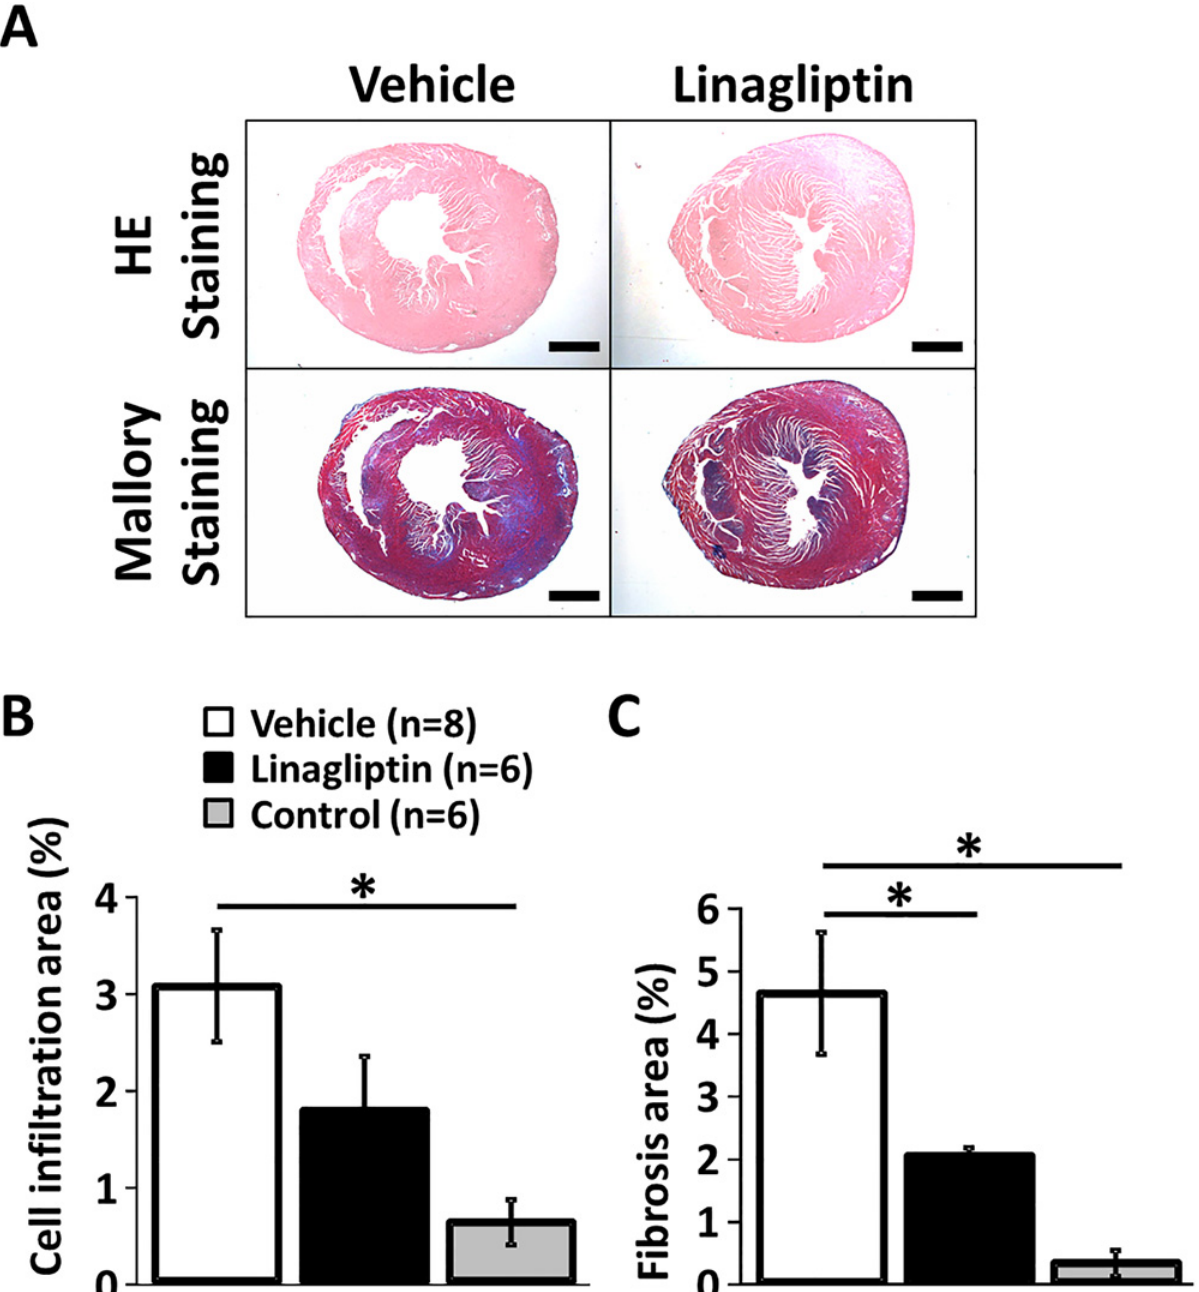
Fig 1. Pathological analysis revealed that a DPP-4 inhibitor prevented cardiac fibrosis in EAM. A, Representative pathological images stained with HE staining and Mallory staining in low (× 20) power microscopic field are presented. B, Quantitative analysis of the cell infiltration area in myocardium. There is no significant difference between the untreated group and the treated group. C, Quantitative analysis of the fibrotic area in myocardium. The untreated group showed severe fibrosis, however, the treated group showed a smaller fibrotic area. * P < 0.05, Fisher ’ s PLSD. Values are mean ± SEM. Scale bars = 1mm